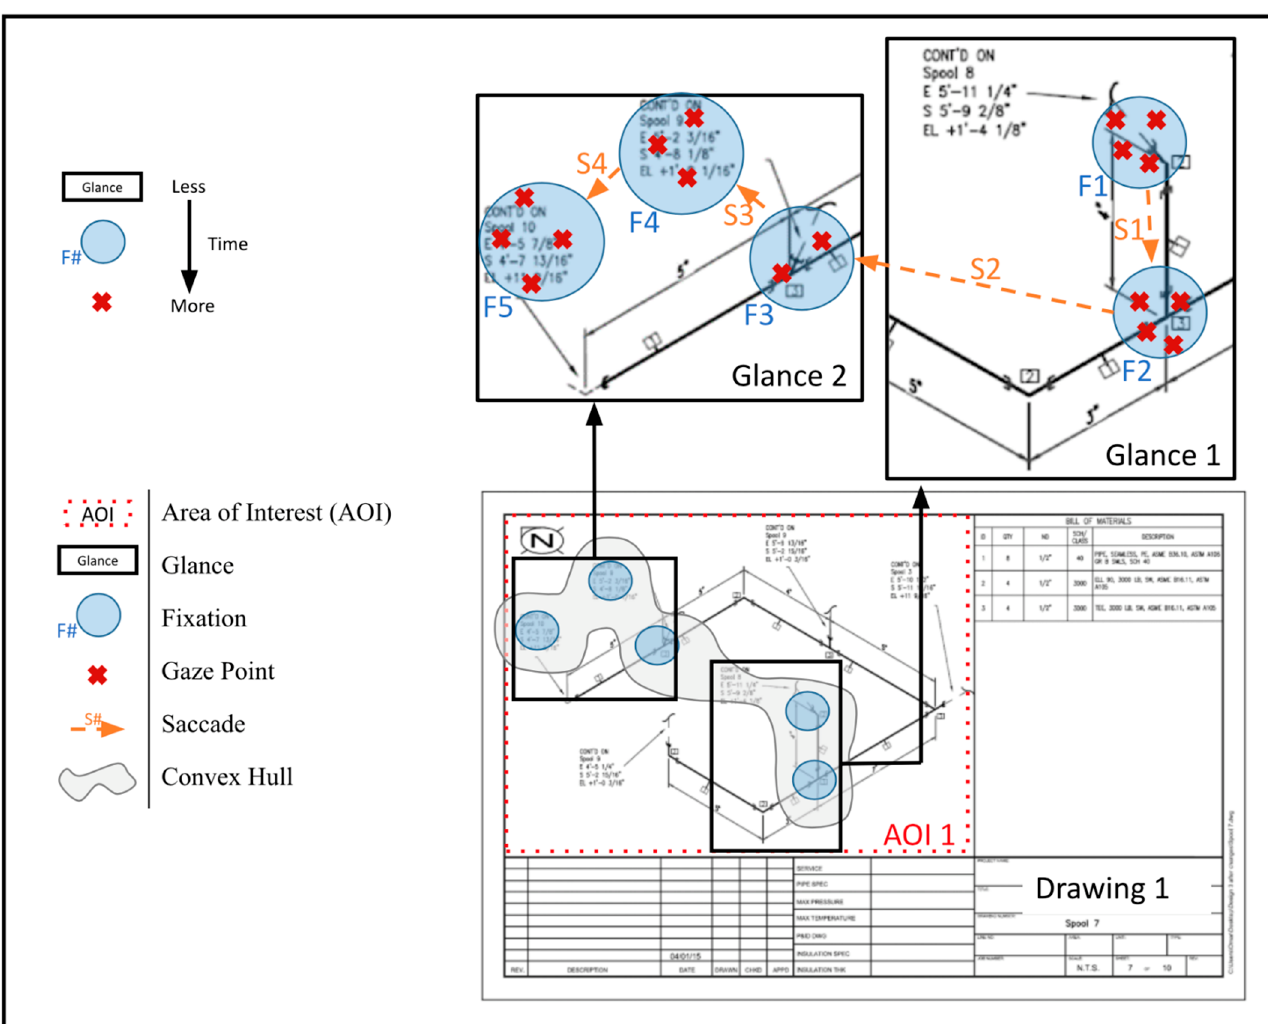
Figure 1. Illustrated eye-tracking terminology (inspired from [8]).